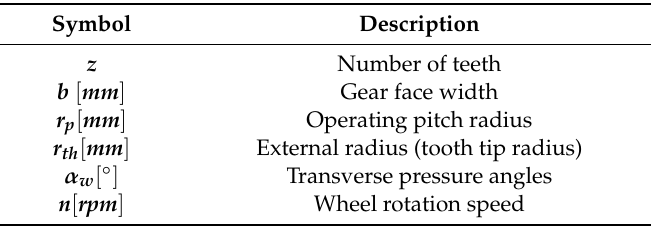
Table 1. Parameters of the meshing losses